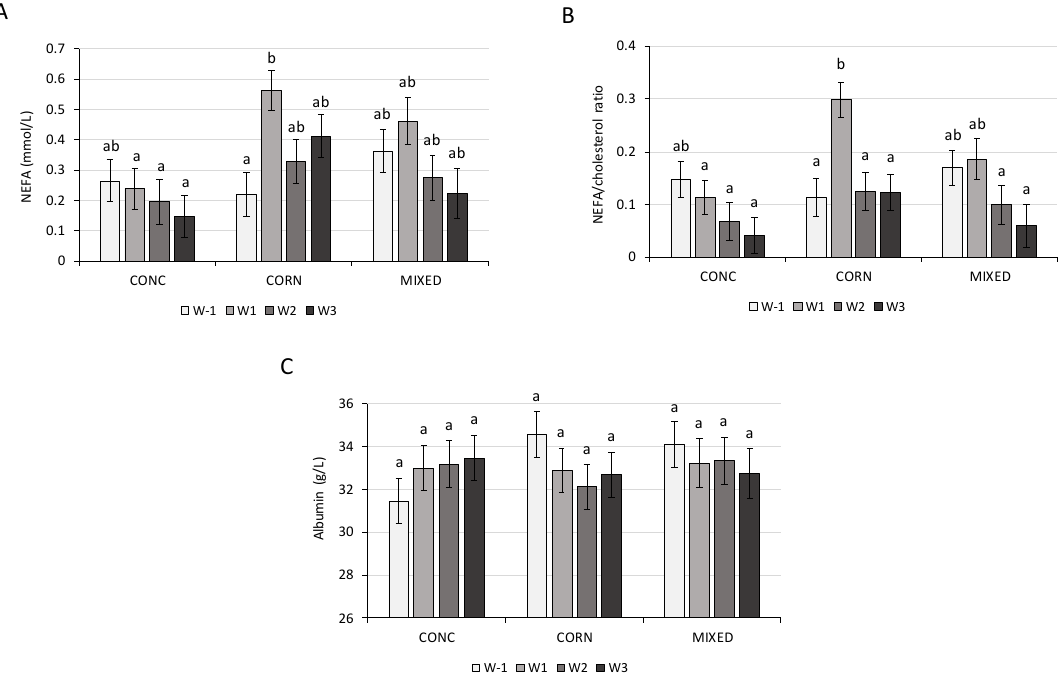
Figure 2. Variation of the blood metabolites: non-esterified fatty acids (NEFA, A); NEFA/cholesterol ratio (B) and albumin (C), between weeks −1 and +3 relative to parturition (W−1 to W3), in cows with different dietary treatments (diet based on concentrate meal and straw (CONC), on corn silage (CORN) or corn and grass silages (MIXED)) given during the dry period and receiving the same lactation diet. Values followed by di ff erent letters (a, b) are significantly di ff erent ( p ≤